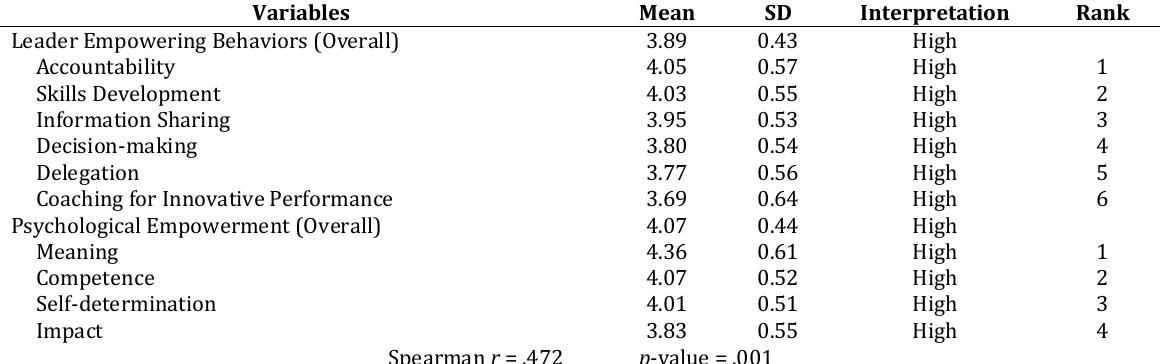
Table 2. Level of leader empowering behaviors and psychological empowerment and relationship between variables